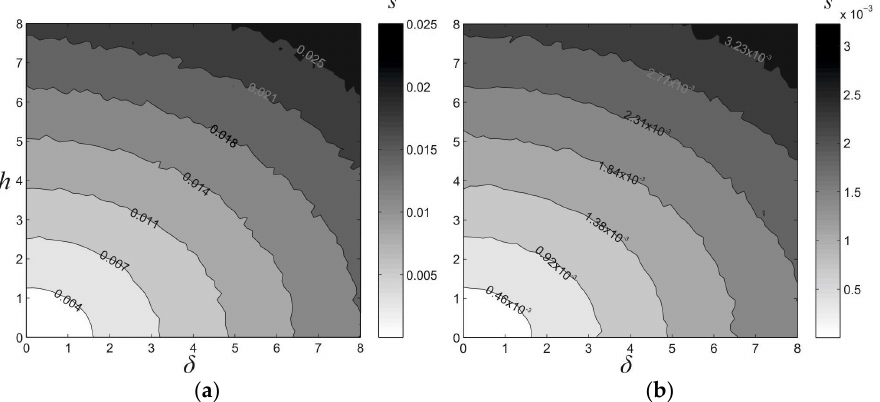
Figure 11. The root-mean-square errors s in the components of reconstructed vector X inv of the error levels δ in the input data and the model error h for the fixed number of measurement points N p = 10 ( a ) and N p = 500 ( b